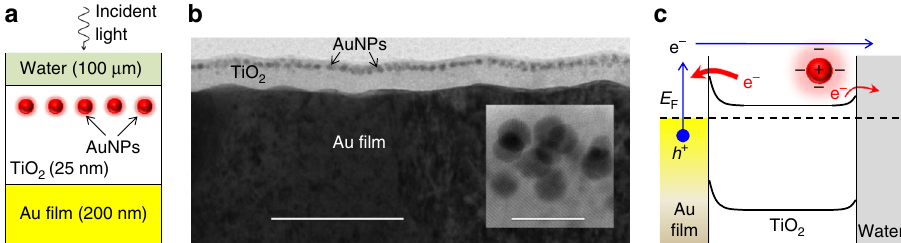
Fig. 1 Schematic and working principle of the dual-plasmon device. a Schematic of the device. b Cross-sectional transmission electron microscope (TEM) image of the device, scale bar 100 nm. The inset shows the Au nanoparticles (AuNPs) at a higher magni fi cation, scale bar 10 nm. c Working principle of the device under the optical excitation of the localized surface plasmon resonance (LSPR) of the AuNPs. The blue arrows indicate the transfer of hot electrons generated from a random surface plasmon polariton (SPP) in the Au fi lm and partially from the interband or intraband transitions of the Au fi lm to the water layer. The red arrows indicate the transfer of hot electrons generated from the AuNPs to the Au fi lm and water layer. The population of hot electrons that are transferred from the AuNPs to the Au fi lm is larger than that to the water layer, owing to the requirement of the redox reaction, indicated by different thicknesses of the red